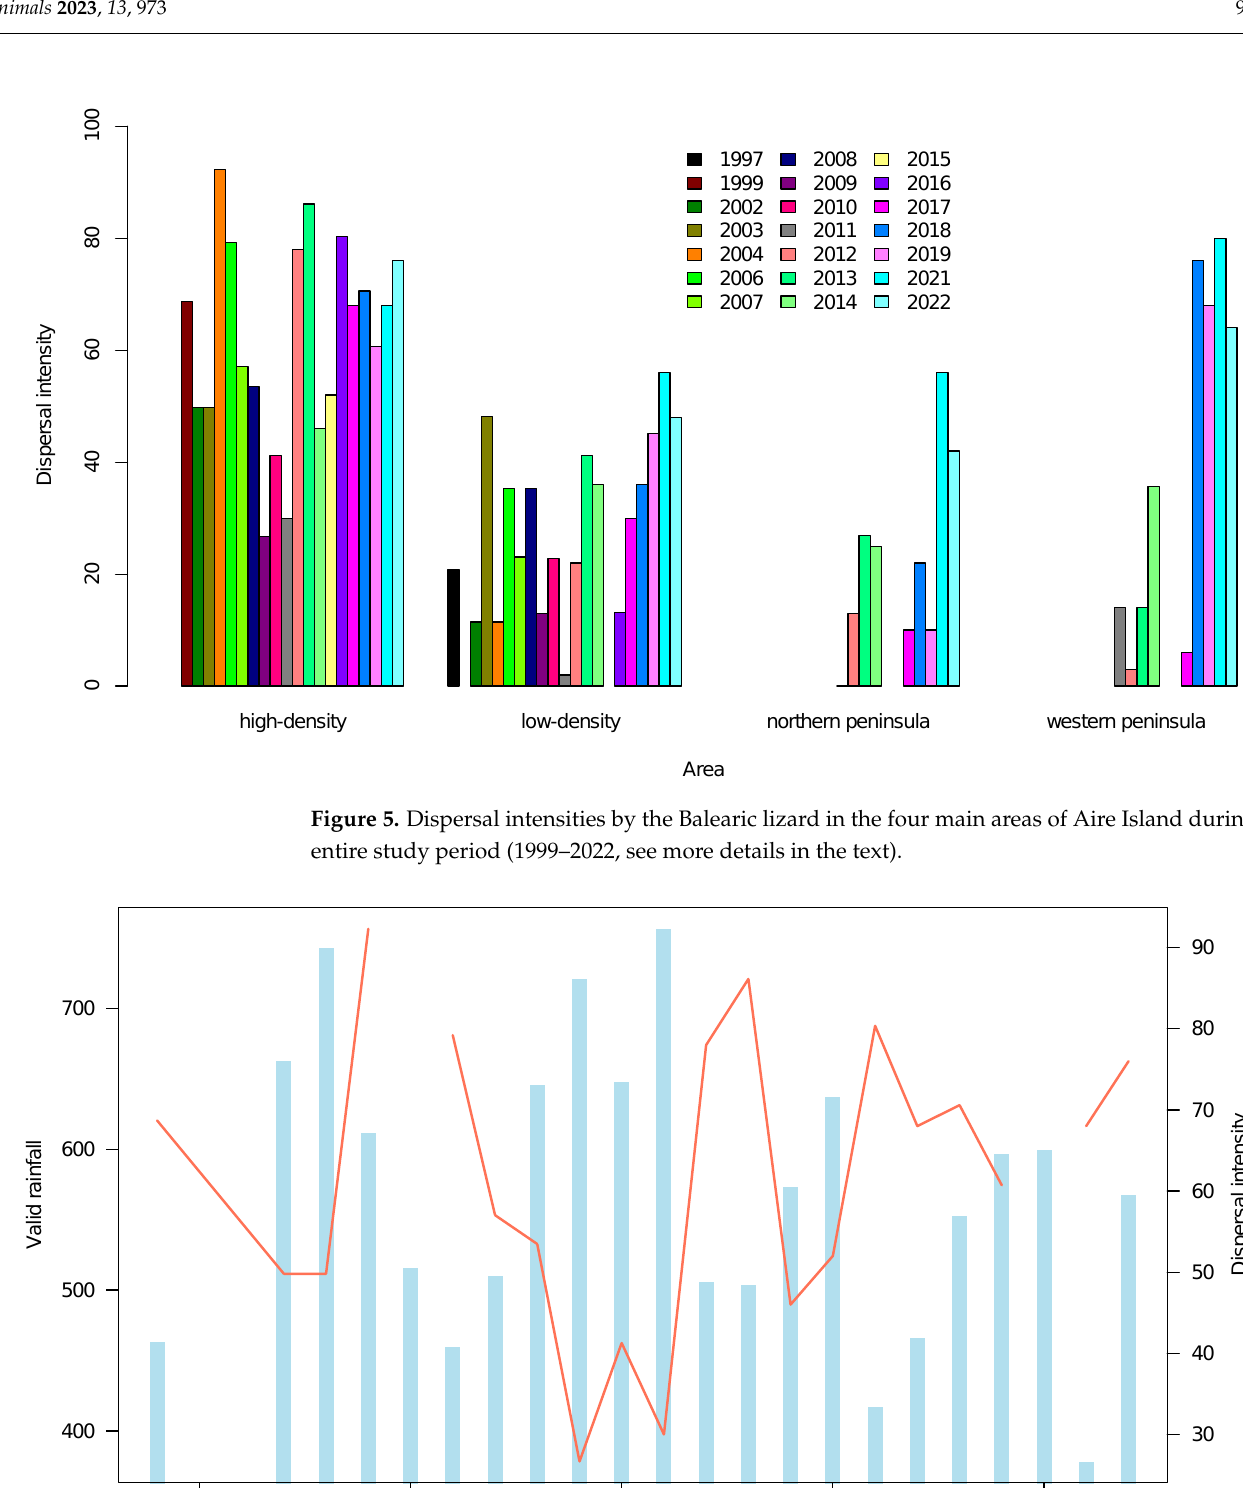
Figure 7. Annual dispersal intensity (red lines, right y -axis) and annual density of Helicodiceros mus- civorus (green bars, individuals/hectare ± SE, left y -axis) in high-density area. The extraordinary in- crease in plant density from 2003 is clearly evident.